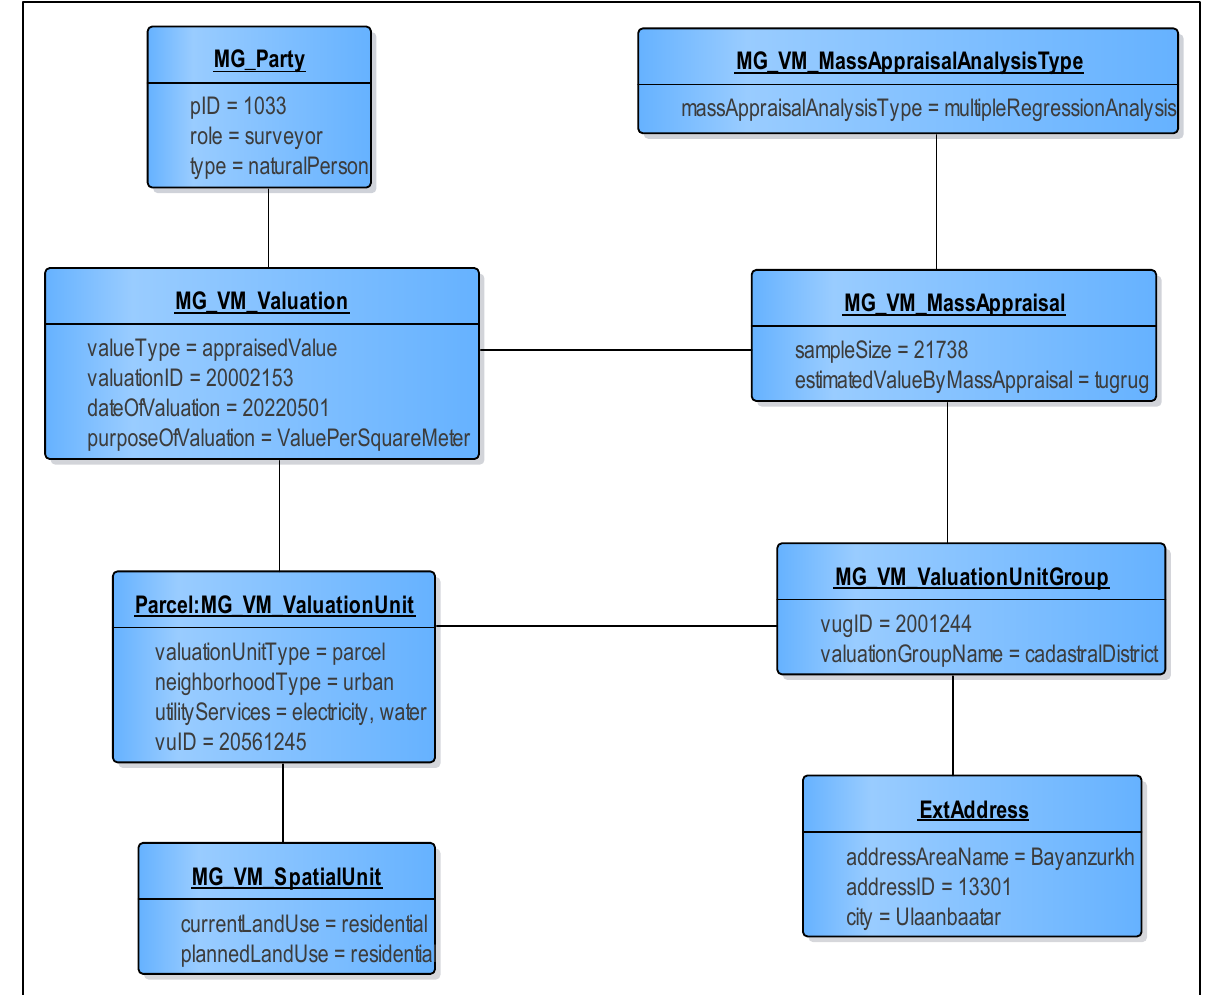
Figure 10. UML object (instance) diagram for recording the mass appraisal procedure.